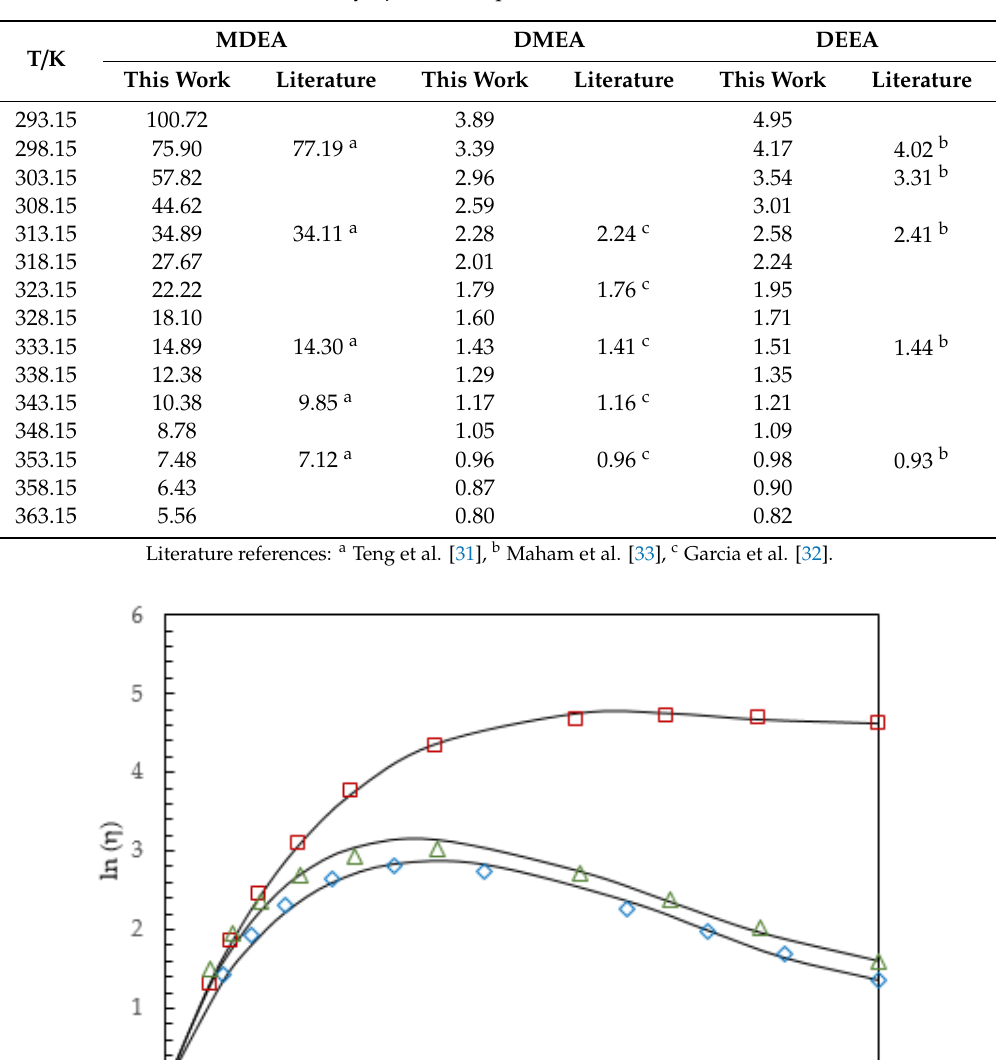
Table 6. Measured viscosity ( η / mPa · s) of pure amines MDEA, DMEA, and DEEA.